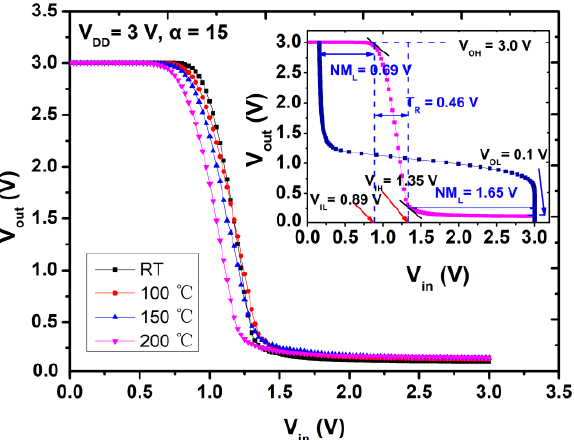
Figure 8. The static voltage transfer curve of the inverter at different temperature from 25 °C to 200 °C with V DD = 3 V; insert: DC output and transfer characteristics of the inverter at 200 °C. Table 3. Noise margins for inverters at different temperature.